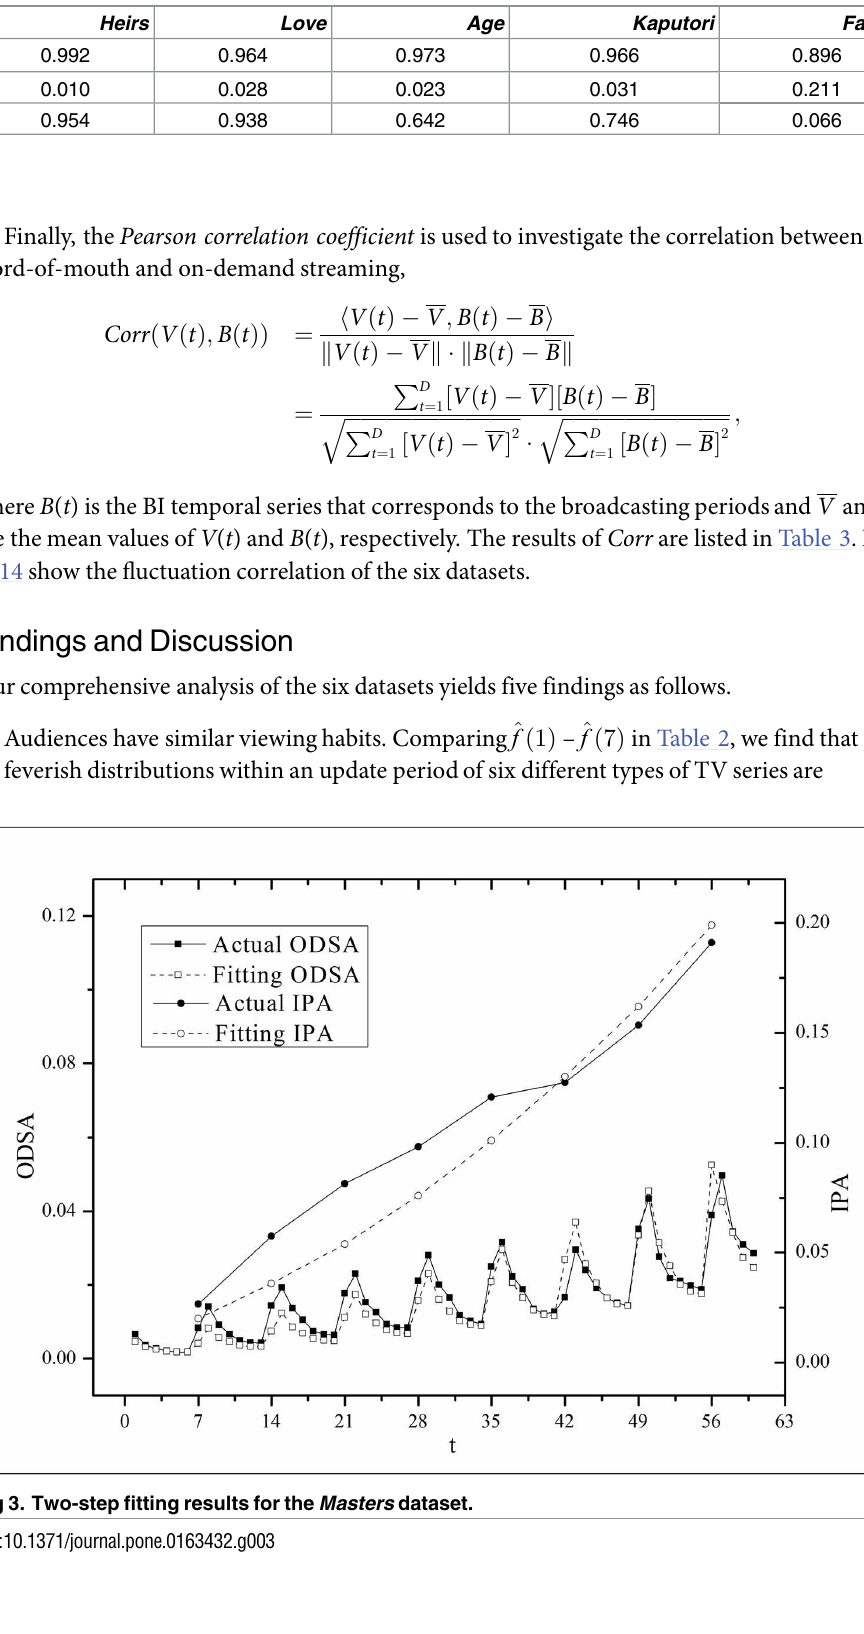
Table 3. Similarity and correlation coefficients of the six datasets.